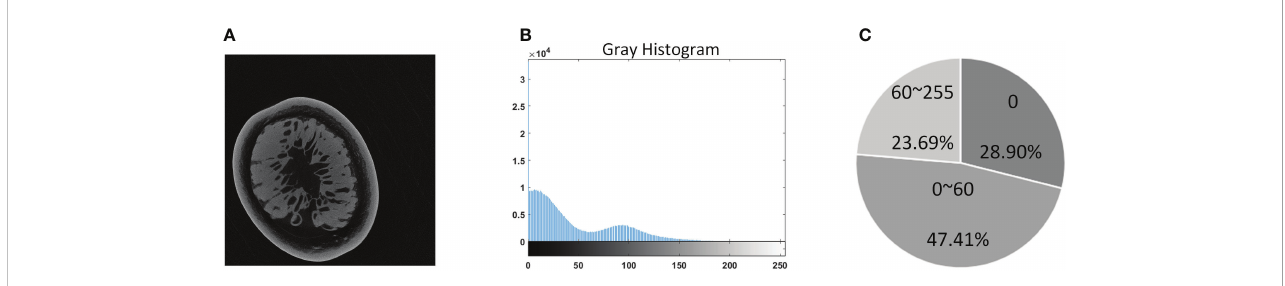
FIGURE 3 Grayscale distribution of tomogram images. (A) Example of a tomogram image. (B) The gray histogram. (C) Visualizes an approximate percentage of pixels in each